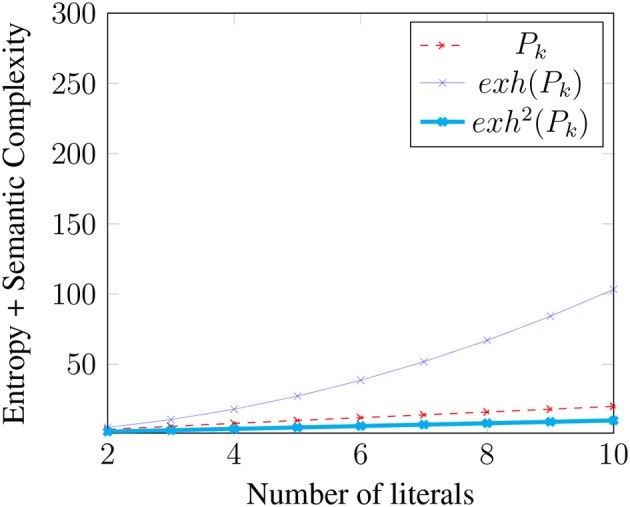
Cost of update (final version).